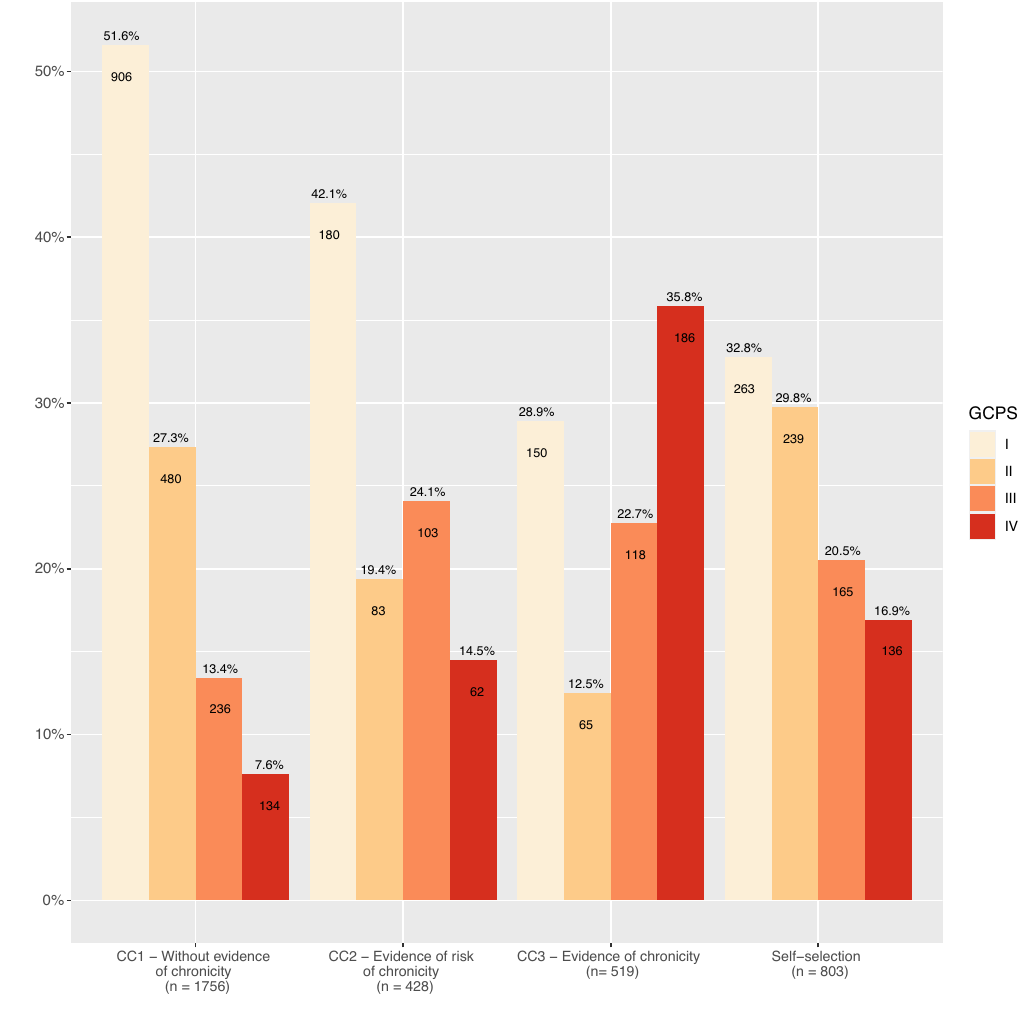
Figure 1. Comparison of actual BP severity with prediction. Comparison of GCPS at baseline with prediction from claims data algorithm according to Freytag et